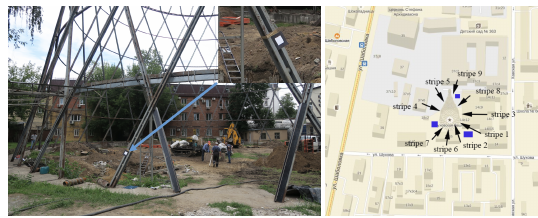
Figure 2. One of the GCPs measured on the basement of the tower (left). Scheme of the 9 UAV strips flown to capture images of the tower